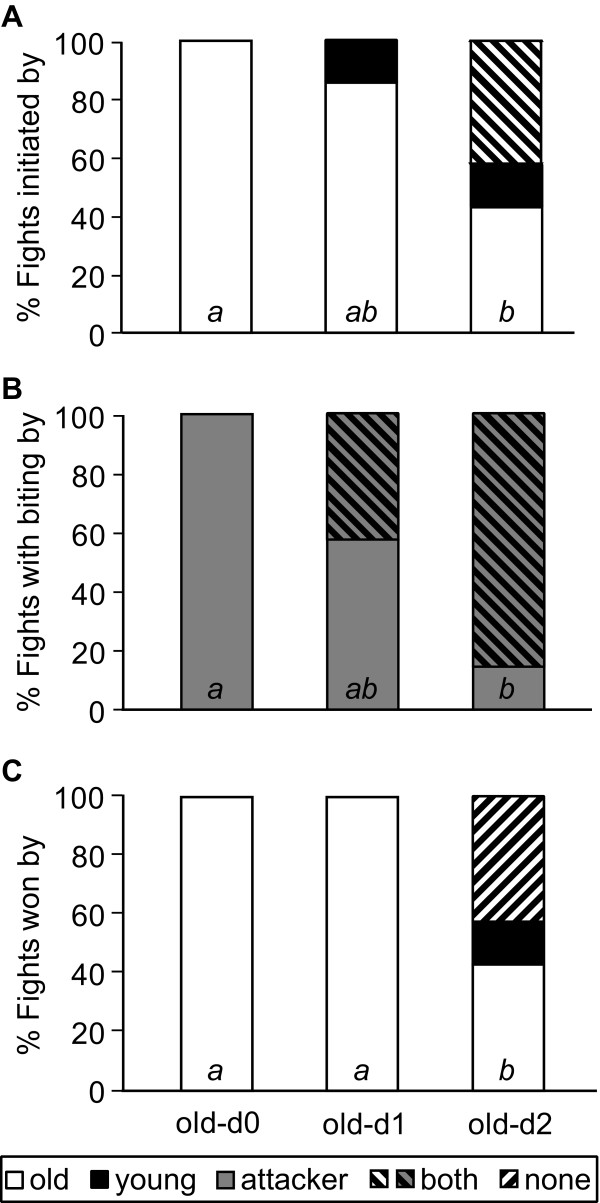
Fight characteristics depending on the age of ergatoid males of the ant Cardiocondyla obscurior. A) Fights were initiated more frequently by the older male when their opponent had eclosed on the day of fighting (old-d0) or was one day old (old-d1) than when the young male was two days old (old-d2). B) Biting was performed only by the attacking male when the opponent was less than one day old (old-d0), whereas both males attacked when the young male was older (old-d1 and old-d2). C) Fights were won exclusively by the older male when the rival was younger than two days (old-d0 and old-d1), yet in interactions between an old and a two-day old male, both males had similar chances of winning. Some fights resulted in the death of both males. Small italic letters indicate significance groups of the white/grey bars.